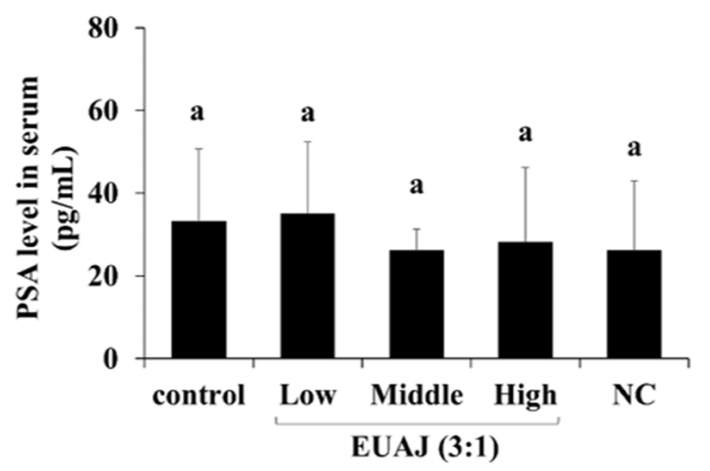
Figure 7. The effects of EUAJ (3:1) on serum PSA level in SD rats. PSA level were measured in serum of SD rats by administration of EUAJ (3:1). Values are presented as means ± SD. Different superscript letters show a significantly difference at p < 0.05, as determined by Duncan’s multiple range test. Control; saline, low; EUAJ (3:1) 20 mg/kg, middle; EUAJ (3:1) 40 mg/kg, high; EUAJ (3:1) 80 mg/kg, NC;